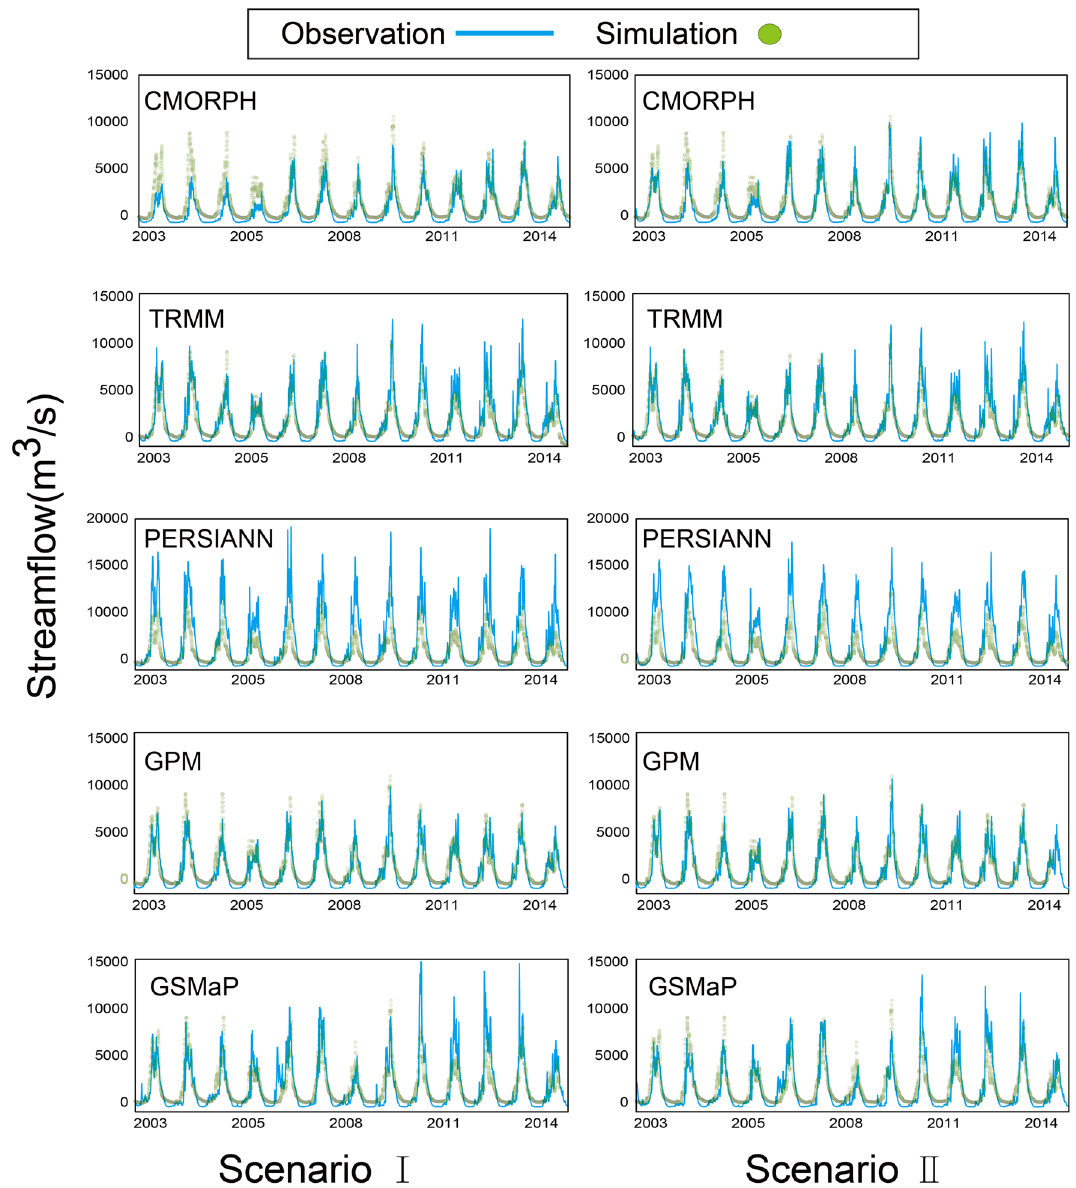
Figure 6. Results of daily streamflow at Nuxia under Scenario I and Scenario